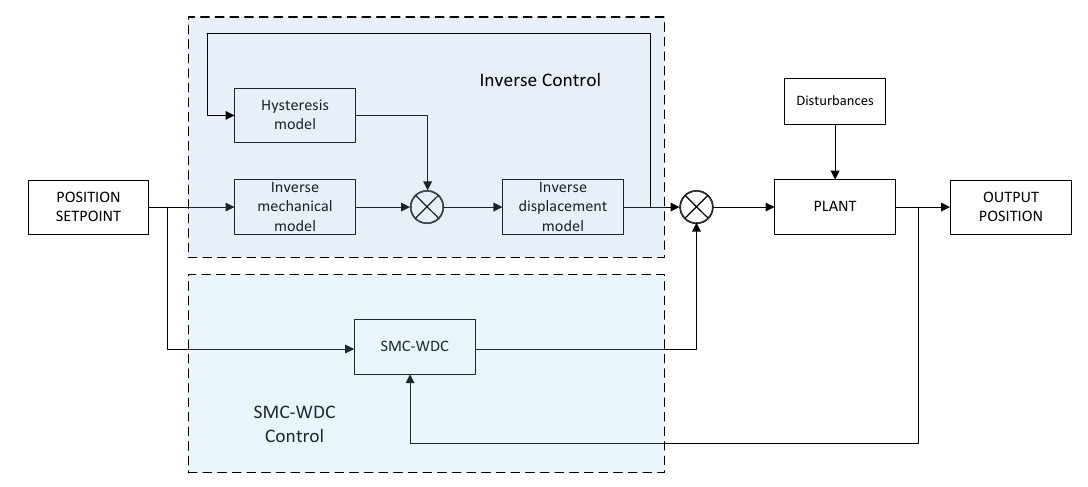
Figure 4. Combined control strategy.